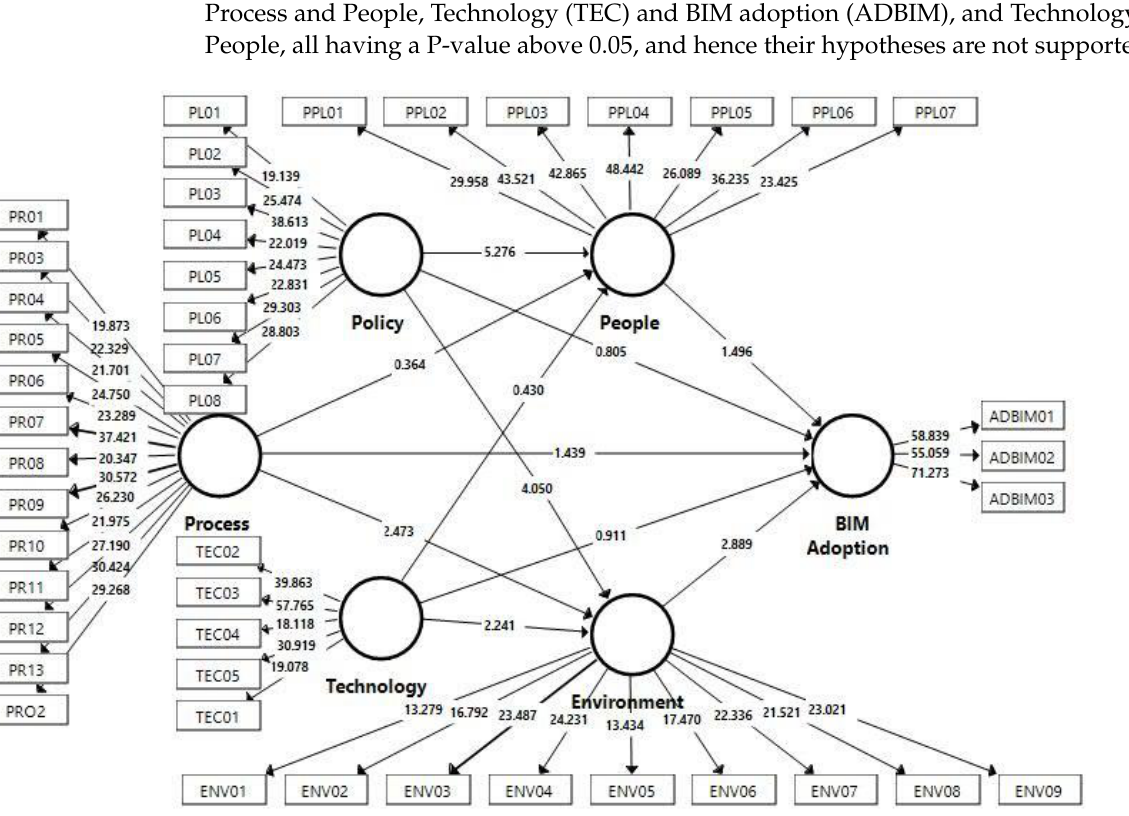
Figure 4. Path coefficient (T-values relative). Table 12. Path Coefficient Result.